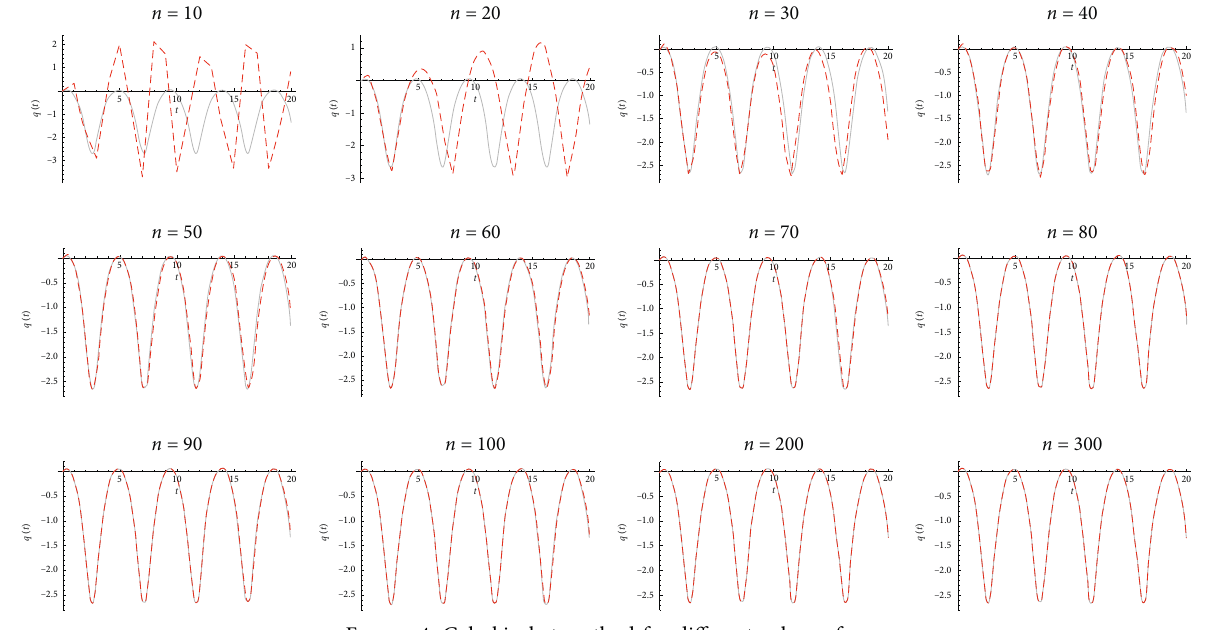
Figure 4: Galerkin hat method for different values of